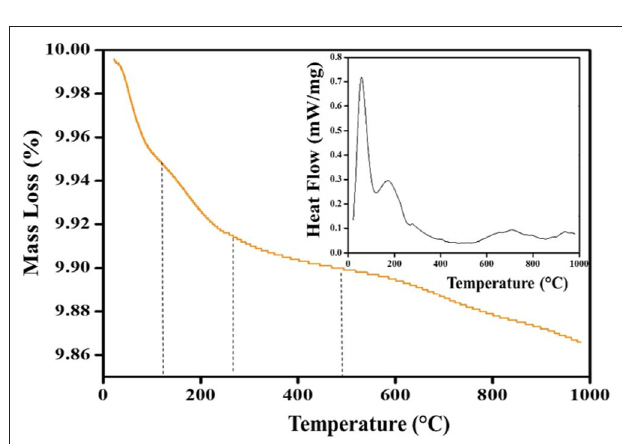
fatty acids/ester endothermically. The exothermic peaks at 98 and 180 ◦ C seen on the DSC curve may be attributed to early phase